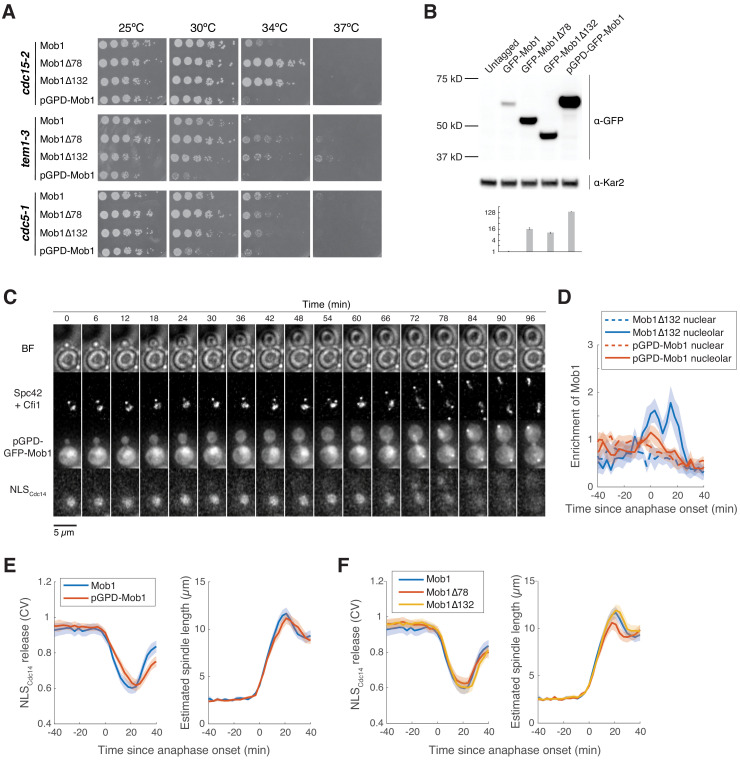
N-terminally truncated Mob1 is hyperactive.(A) Fivefold serial dilutions of cdc15-2 (A41424, A41425, A41426, A41427), tem1-3 (A41429, A41430, A41431, A41428), and cdc5-1 (A41432, A41433, A41434, A41435) harboring the indicated MOB1 constructs in YEP + 2% glucose at the indicated temperatures. (B) Immunoblot (top) and quantification (bottom) of untagged (A2587), full-length (A41351), and truncated GFP-Mob1 (A41352, A41353) as well as full-length GFP-Mob1 expressed from the pGPD/TDH3 promoter (A41350). (C) Localization of GFP-Mob1 expressed under the control of pGPD promoter (A41595) during the cell cycle. Cells were grown and imaged as in Figure 1E. Increased nuclear but not nucleolar localization of Mob1 was observed. (D) Enrichment of Mob1Δ132 (A41213, n = 14 cells) and pGPD-Mob1 (A41595, n = 17 cells) in the nucleolus (solid lines) compared to the nucleus (dashed lines) as a function of cell cycle progression. Cells were grown and imaged as in Figure 1E. (E) Kinetics of mitotic exit network (MEN) activation as measured by the release of NLSCdc14 reporter from the nucleus (see Figure 1—figure supplement 2) and anaphase progression as indicated by spindle length for cells harboring Mob1 (A41213, n = 62 cells) or pGPD-Mob1 (A41595, n = 43 cells). pGPD-Mob1 slightly delays MEN activation and exit from mitosis. (F) Kinetics of MEN activation and anaphase progression for experiments shown in Figure 1E. Mob1Δ78 slightly accelerated mitotic exit. For graphs in (D–F), single cell traces were aligned based on anaphase onset and averaged. Solid lines represent the average, and shaded areas represent 95% confidence intervals.